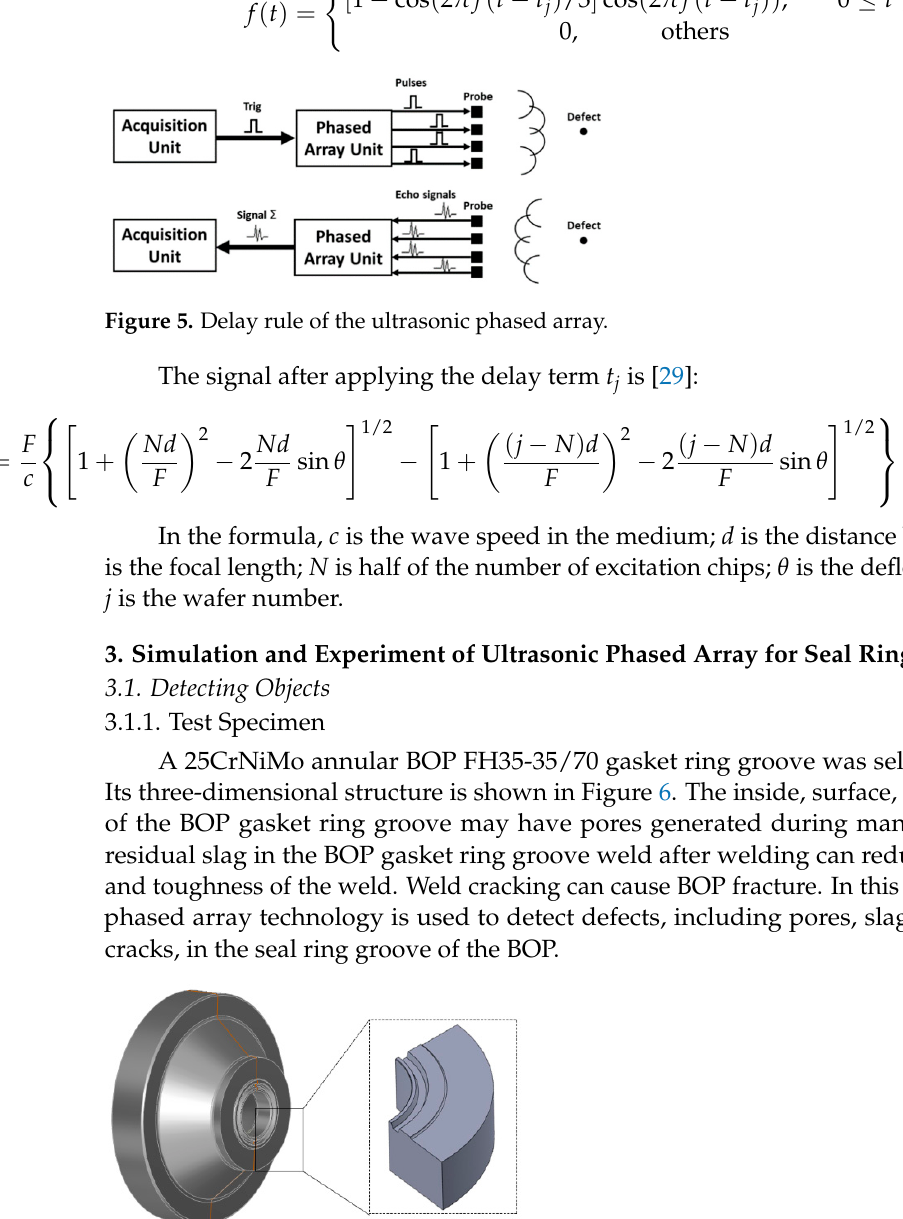
and porosity defects in the gasket ring groove, as shown in Table 1. The distances from the center of the rightmost section of artificial defects 1# and 2# to the right vertical section of the test specimen body are 73 mm and 104 mm, and the dimensions are 5 × 3 × 0.2 mm and 8 × 5 × 0.2 mm, respectively, as shown in Figure 7. The distances from the center of the rightmost section of artificial defects 3#, 4#, and 5# to the vertical section of the right- most section of the test specimen body are 138 mm, 160 mm, and 184 mm, and the dimen- sions are Φ 3 × 8 mm, Φ 2 × 5 mm, and Φ 2 × 40 mm, respectively. The vertical distance between all defects and the upper surface of the test specimen is 8 mm. The number 11 in Figure 7 is the plane part of the test specimen, and the number 12 is steel ring grooves. Table 1. Artificial defect parameters. Defect Number